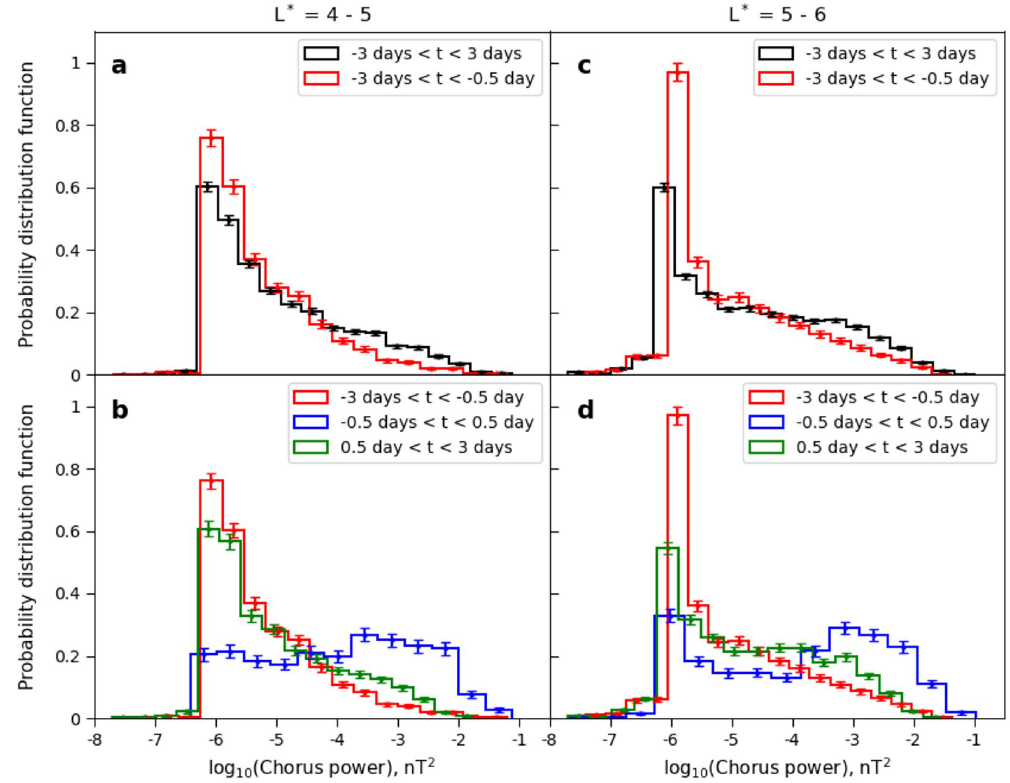
Figure 6. Normalised chorus wave power occurrence distribution in different time intervals in the L* range 4–5 ( a , b ) and 5–6 ( c , d ). Chorus wave power in logarithmic scale is plotted along the x axis and the normalised occurrence distribution is plotted along the y